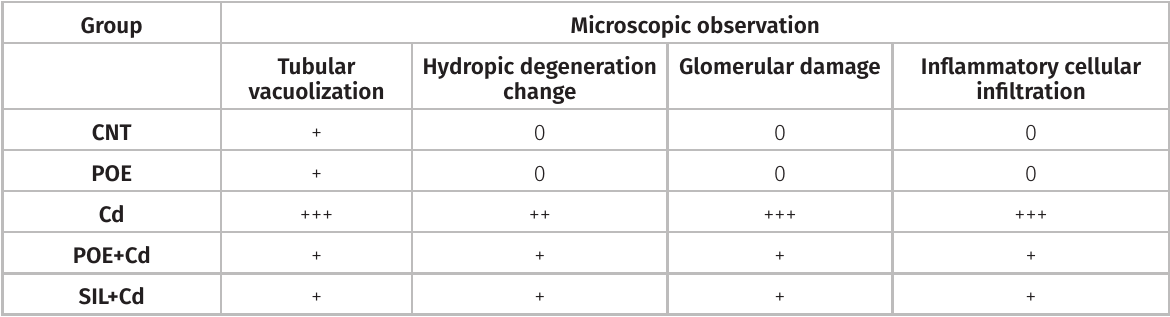
Table I. P. ostreatus extract (POE) ameliorates histopathological kidney damages induced by cadmium . Group